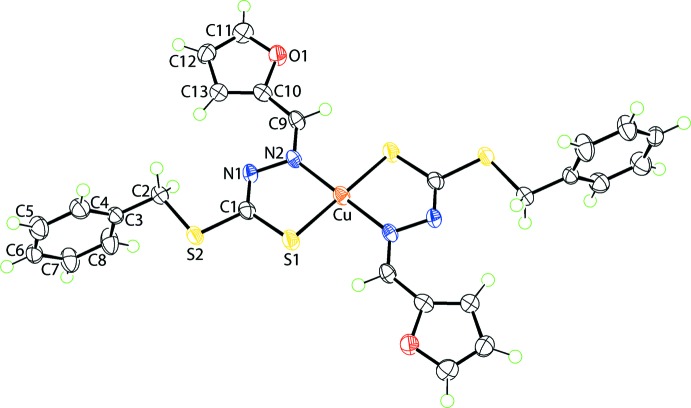
The mol­ecular structure of (I) showing the atom-labelling scheme and displacement ellipsoids at the 70% probability level. Unlabelled atoms are related by the symmetry operation 1 − x, 1 − y, 1 − z.